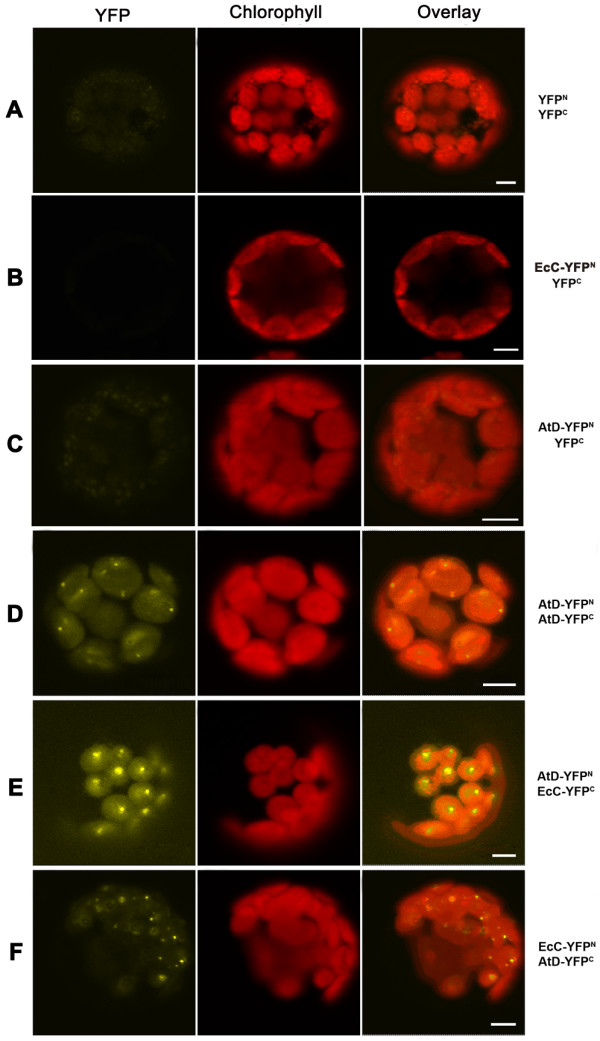
Interactions of EcMinC and AtMinD examined by BiFC assay in Arabidopsis protoplasts. (A) coexpression of 35S-YFPN and 35S-YFPC; (B) 35S-TP-EcMinC-YFPN and 35S-YFPCcoexpression; (C) 35S-AtMinD-YFPN and 35S-YFPCcoexpression; (D) 35S-AtMinD-YFPN and 35S-AtMinD-YFPCcoexpression; (E) 35S-AtMinD-YFPN and 35S-TP-EcMinC-YFPC coexpression; (F) 35S-TP-EcMinC-YFPN and 35S-AtMinD-YFPCcoexpression. Bars, 5 μm.